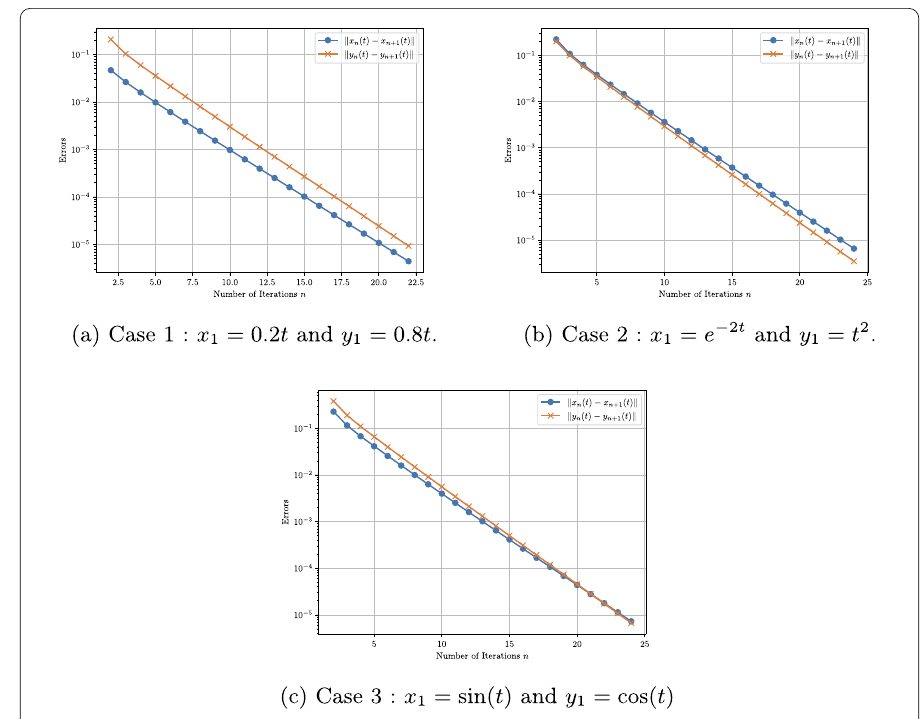
Figure 6 Error plotting of (cid:4) x n +1 – x n (cid:4) and (cid:4) y n +1 – y n (cid:4) in Example 5.2, the y -axis is illustrated on a logscale